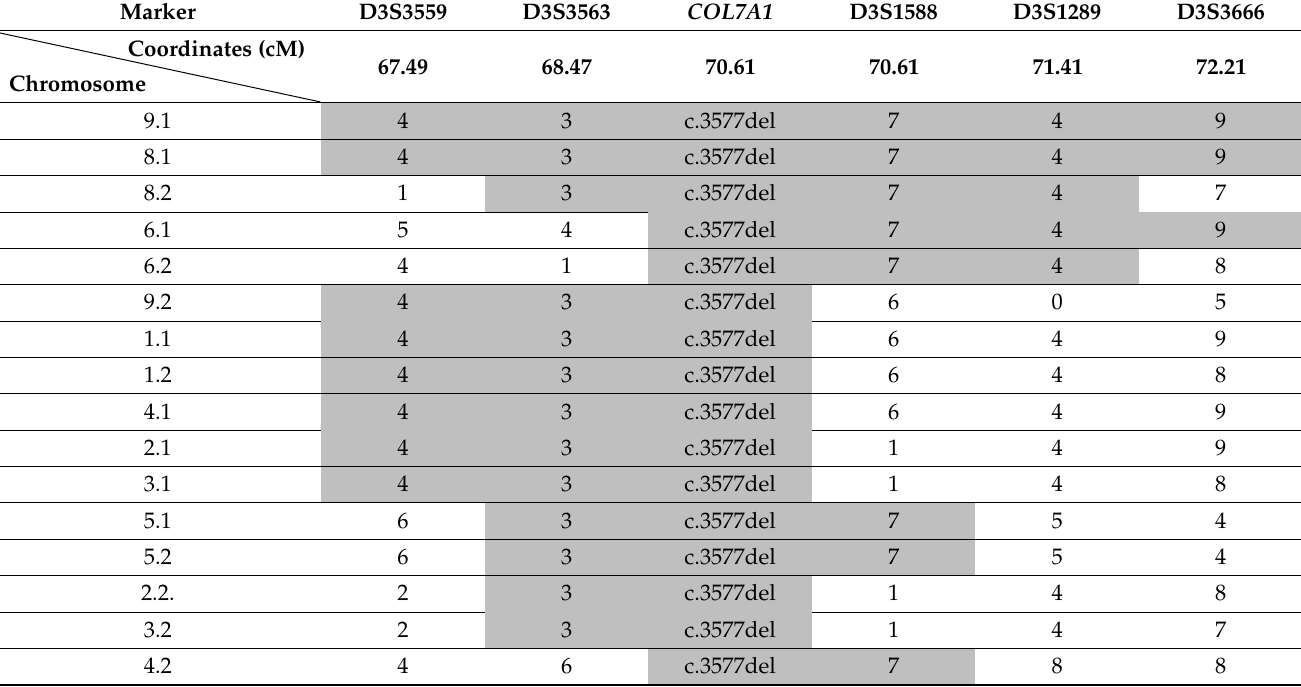
Table 1. Haplotypes of chromosomes with the c.3577del mutations using markers D3S3559, D3S3563, D3S1588, D3S1289, and D3S3666. The assumed ancestral haplotype is highlighted in gray.